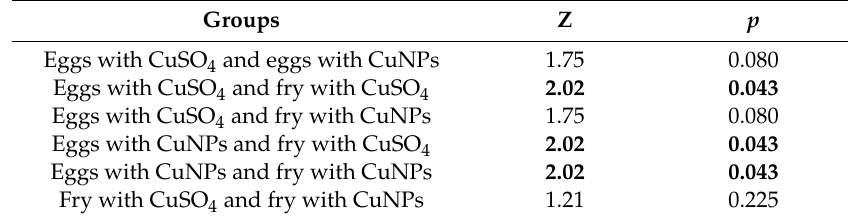
Table 6. Significant di ff erences in the Cu contents in the rainbow trout eggs and fry after swelling with di ff erent concentrations of CuSO 4 and CuNPs. The statistically significant correlations are marked in bold ( p <